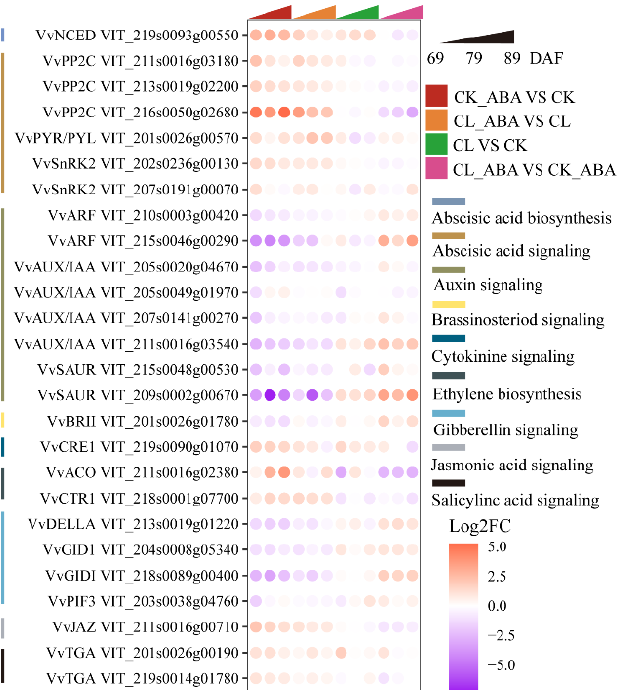
Figure 3. The effects of carbon limitation and exogenous ABA treatment on the mRNA levels of hormone biosynthesis and signaling genes during the first three developmental stages. CK_ABA vs. CK indicate the differential changes in genes in the CK_ABA treatment vs. CK as control. The following three combinations have the same meaning as above. The three columns from left to right corresponding to each combination represent the changes in gene expressions at 69 DAF, 79 DAF, and 89 DAF. In the dot plot, red represents upregulation of mRNA levels in genes, and purple represents downregulation of mRNA levels in genes. The colors of circles represent the intensity of the fold changes in gene expressions (log 2 FC), and the white represents no influence on the gene ex ‐ pression.